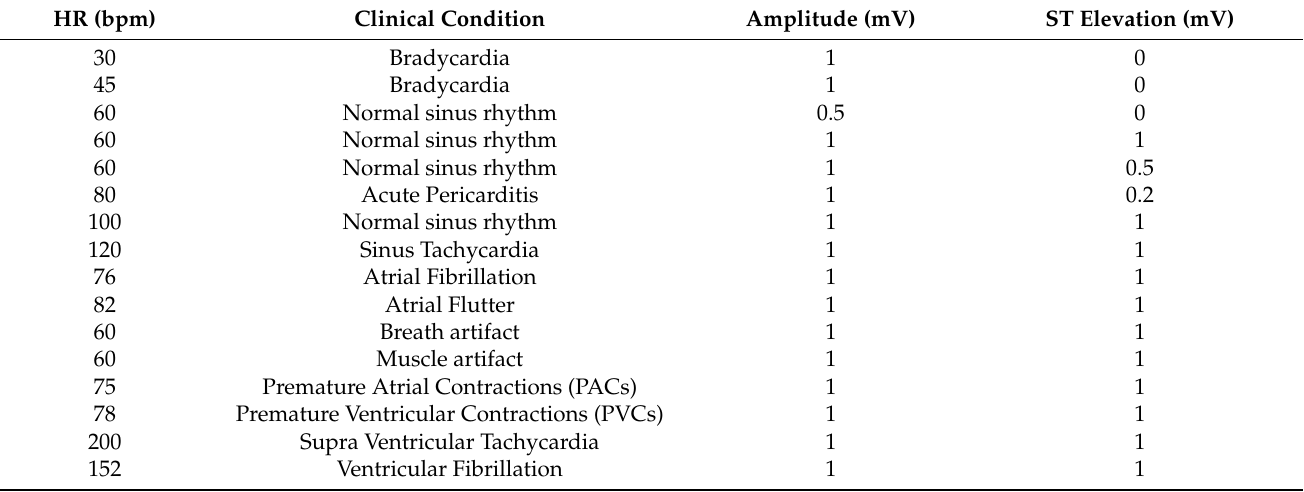
Table 1. Simulated patient description: heart rate (HR), clinical condition, ECG amplitude, and elevation of the ST